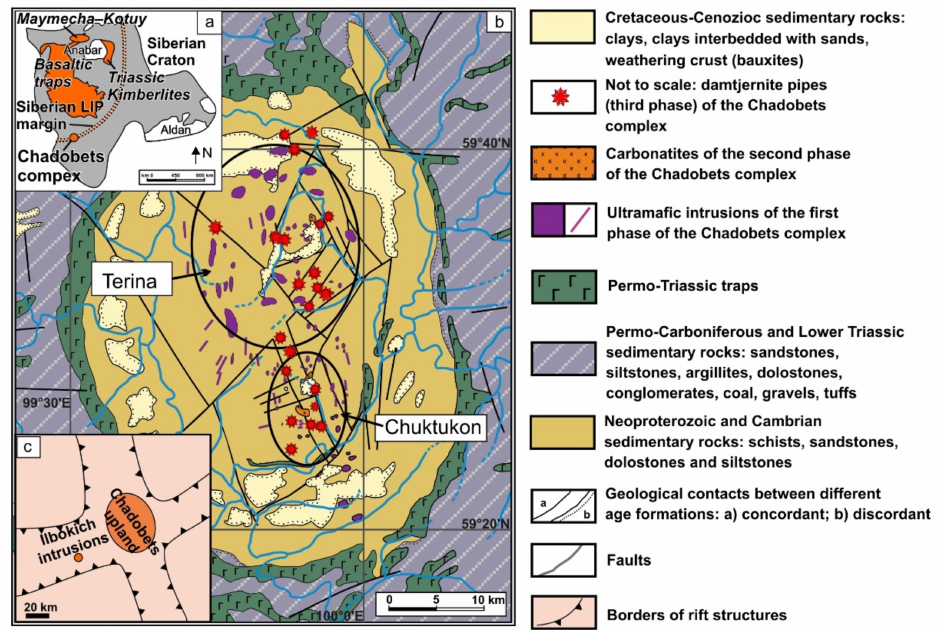
Figure 1. ( a ) Location of the Chadobets alkaline complex within the Siberian large igneous province (LIP) on the Siberian craton [37]. ( b ) Geological map of the Chadobets ultramafic lamprophyre (UML)- carbonatite complex [27,34]. ( c ) Location of the Devonian Ilbokich complex within the Angara-Kotuy rift system